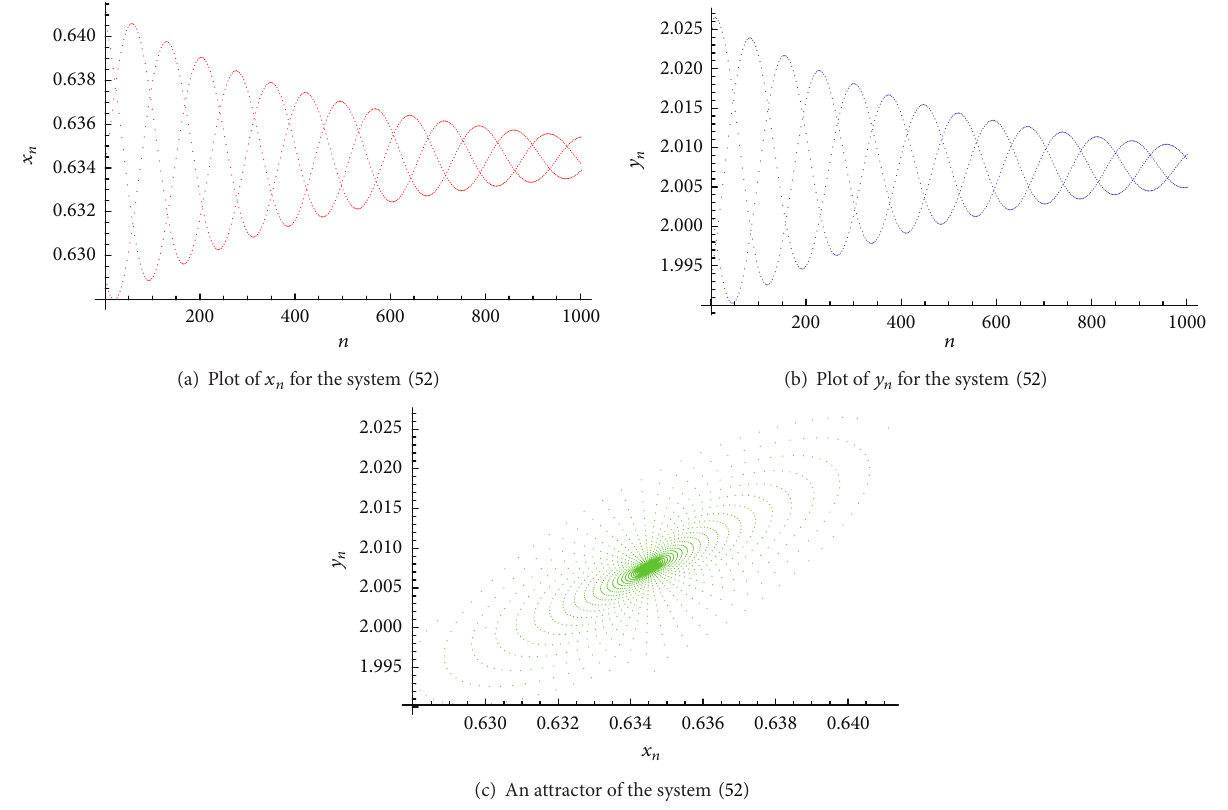
Figure 3: Plots for the system